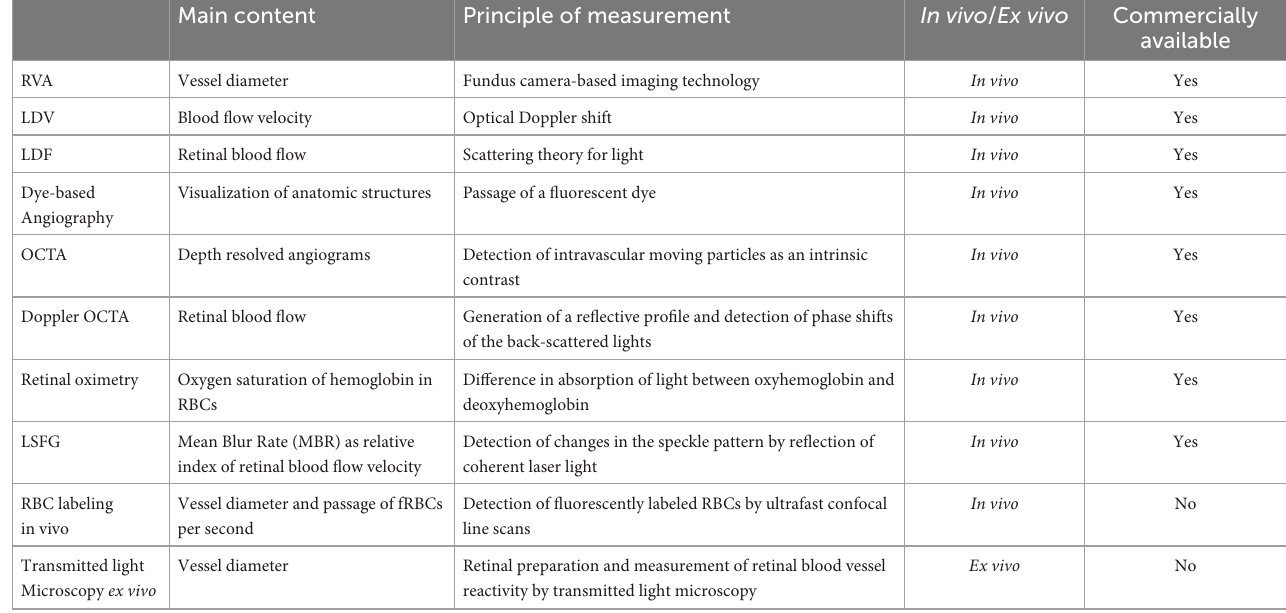
TABLE 1 Overview of the described methods to measure blood flow and vascular reactivity in the retina. Main